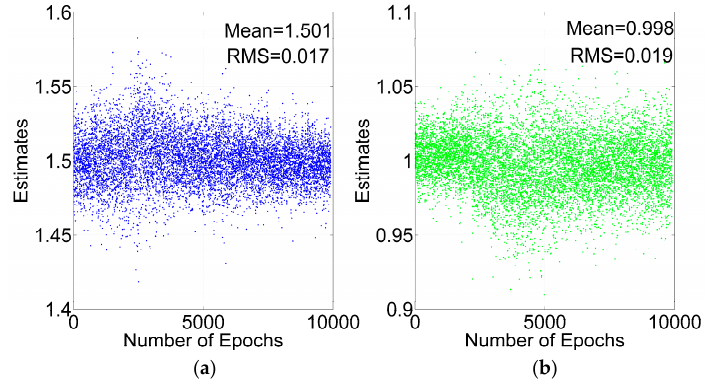
Figure 9. Cycle slips estimates for GPS + BDS: 1.5 Cycles ( a ); 1 Cycle ( b ).